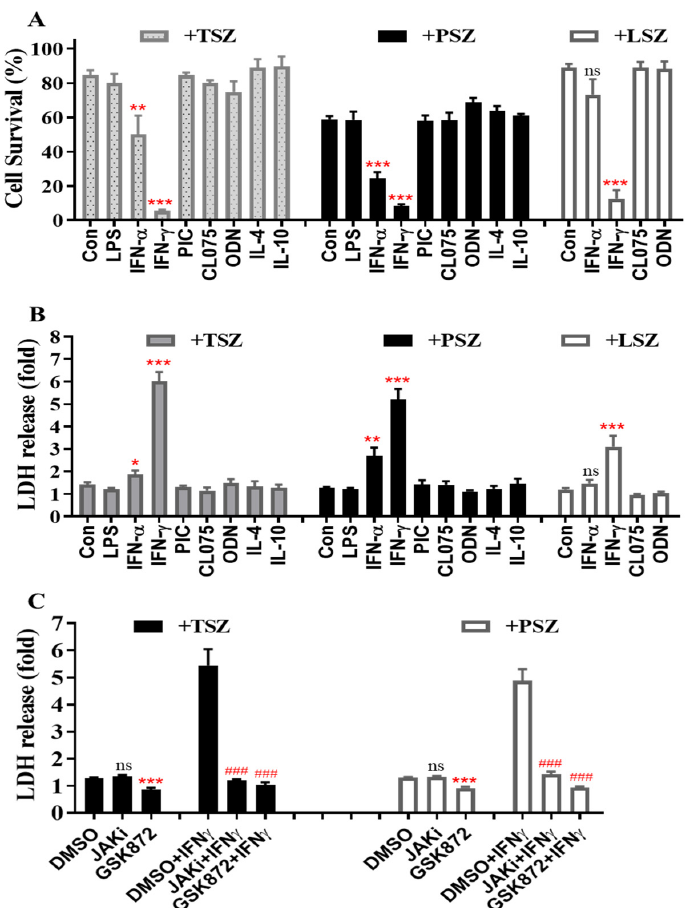
Figure 1. IFN γ preferentially promotes cell death and the release of LDH induced by various necroptosis inducers in primary AECs. Mouse primary AECs were incubated with LPS (100 ng/mL), IFN α 2 (50 ng/mL), IFN γ (50 ng/mL), poly(I:C) (PIC, 0.5 μ g/mL), CL075 (1 μ g/mL), ODN1585 (1 μ M), IL-4 (15 ng/mL), or IL-10 (15 ng/mL) for 24 h, then treated for 6 h with TNF α (15 ng/mL) plus 100 nM Smac mimetic AZD5582 and 25 μ M z-VAD-FMK (TSZ), poly(I:C) (0.2 μ g/mL) plus 100 nM Smac mimetic AZD5582 and 40 μ M z-VAD-FMK (PSZ), or LPS (200 ng/mL) plus 100 nM Smac mimetic AZD5582 and 25 μ M z-VAD-FMK (LSZ). ( A ) AEC viability was assessed by MTS assay